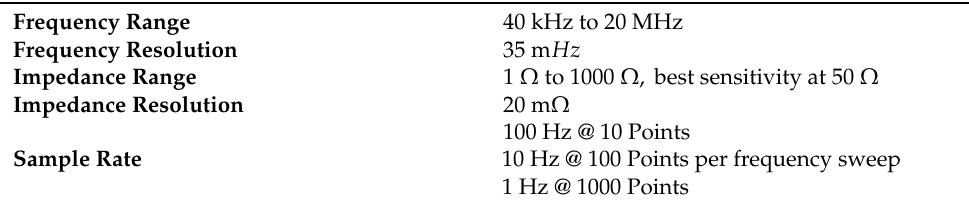
Table 1. Specifications and features of the measurement hardware.